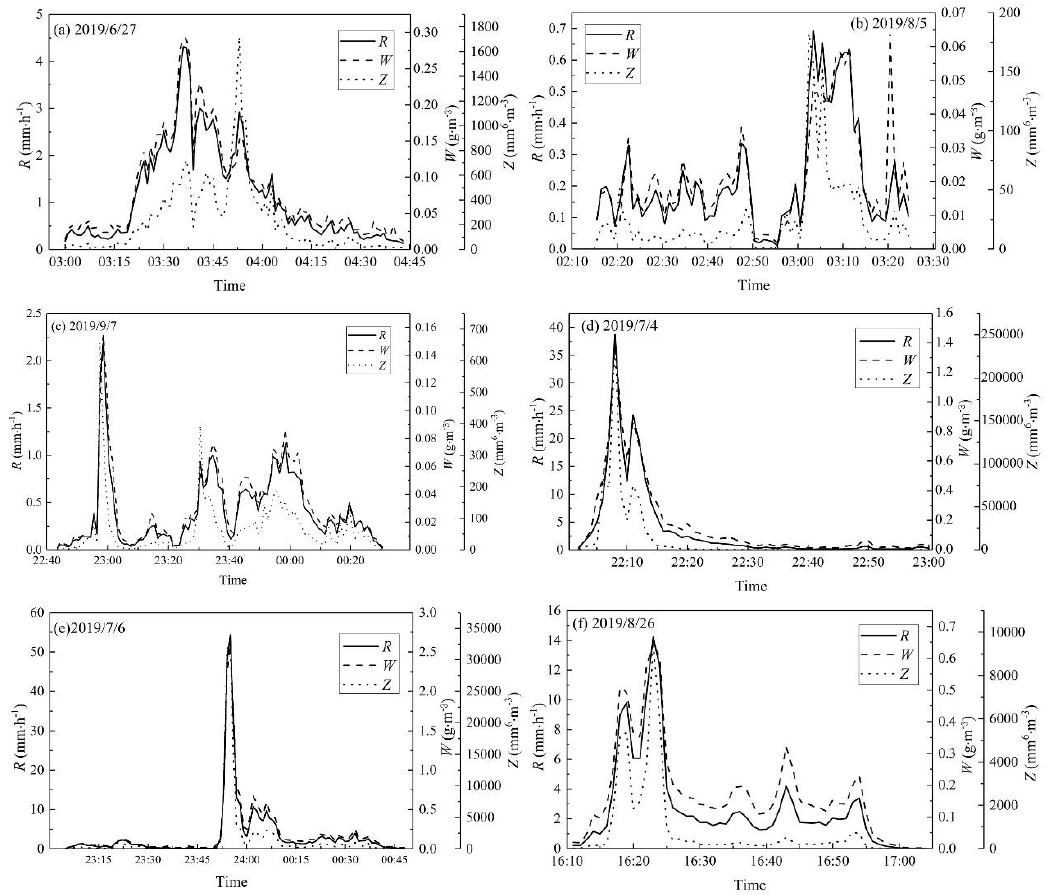
Figure 4. Changes of microphysical parameters (i.e., R , W , and Z ) over time for precipitation events of ( a ) 2019/6/27 3:00-4:43, ( b ) 2019/8/5 2:16–3:25, ( c ) 2019/9/7 22:44–2019/9/8 00:31, ( d ) 2019/7/4 22:02–23:00, ( e ) 2019/7/6 23:05–2019/7/7 00:48, and ( f ) 2019/8/26 16:11–17:04.